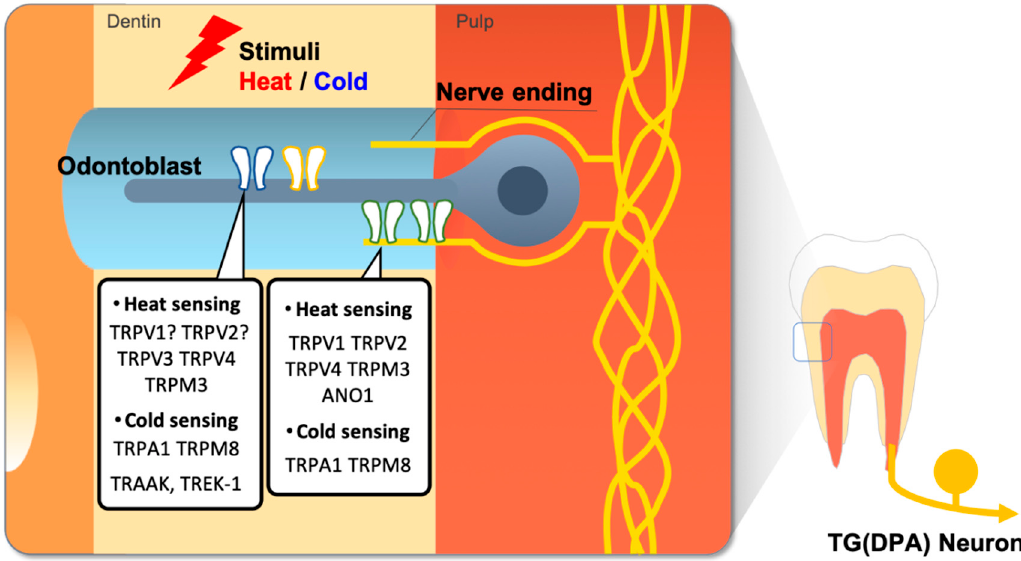
Figure 2. Thermosensitive ion channels in the dental sensory system. External heat or cold stimuli cause activation of thermosensitive ion channels in dental primary afferent (DPA) nerve ending or odontoblast cells, therefore dental pain transduces from thermal stimuli.